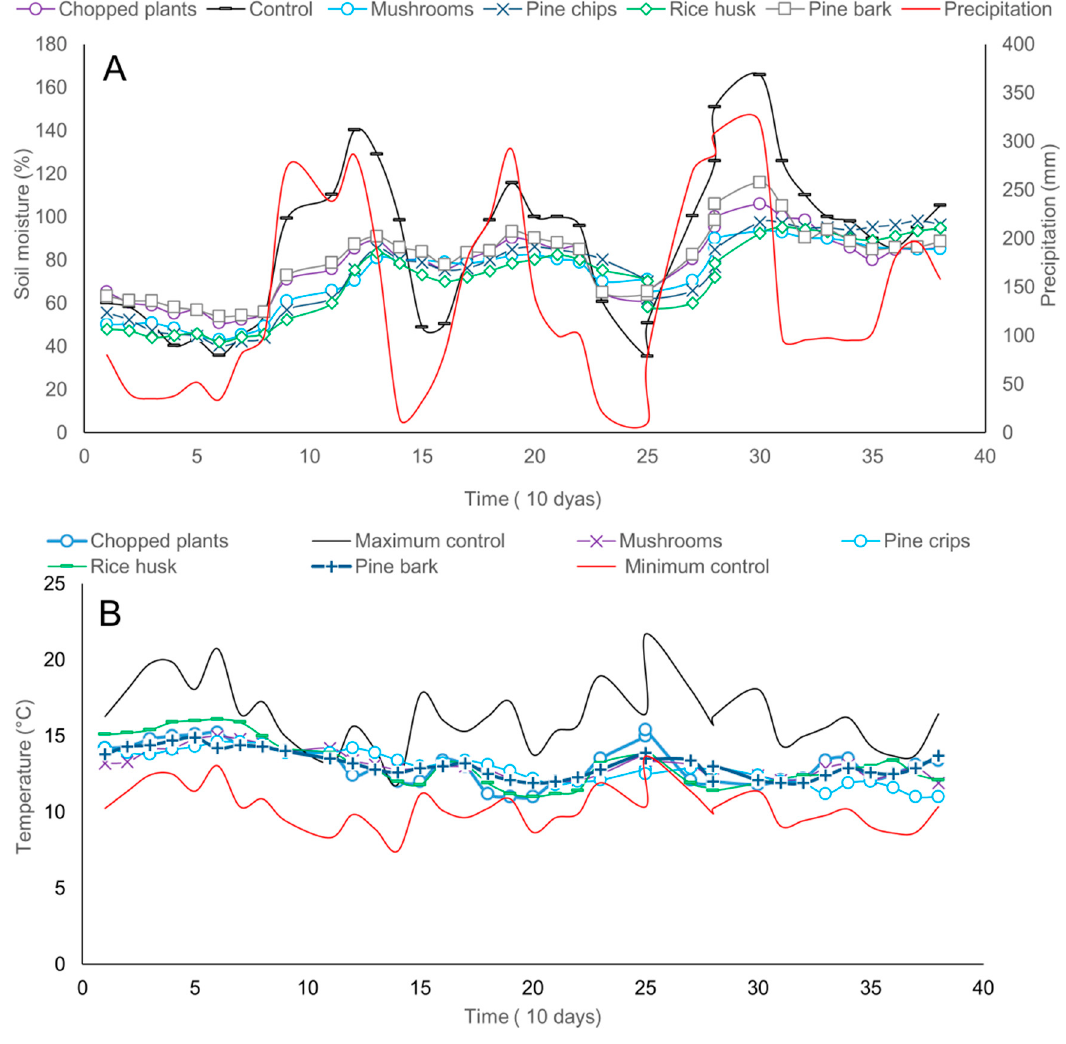
Figure 4. Dynamics of soil moisture ( A ) and temperature ( B ) within the soil profile through time as a result of the addition of organic mulch in avocado plants.